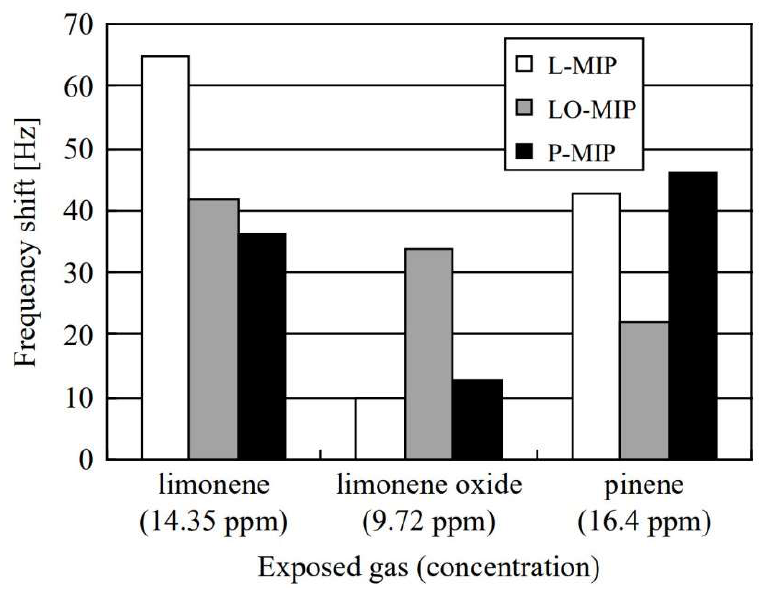
Figure 12. Response of QCM-MIP sensors for limonene, limonene oxide and pinene (L–MIP, LO–MIP and P–MIP) for each of the analytes. MIPs were prepared using a 1:4:20 ratio of template, methacrylic acid and ethylene glycol, which were then cast onto QCM surfaces following polymerization. Reproduced with permission [149].